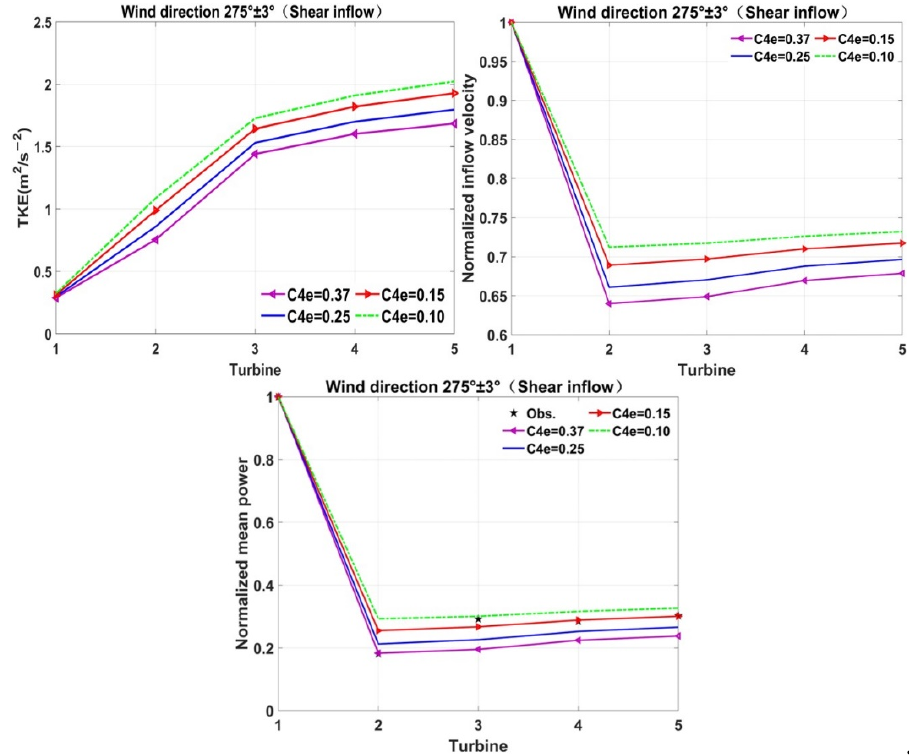
Figure 20. Effects of different C 4 ε values on TKE, inflow wind speed and power output under shear inflow conditions when the incoming wind direction is 275 ± 3°.